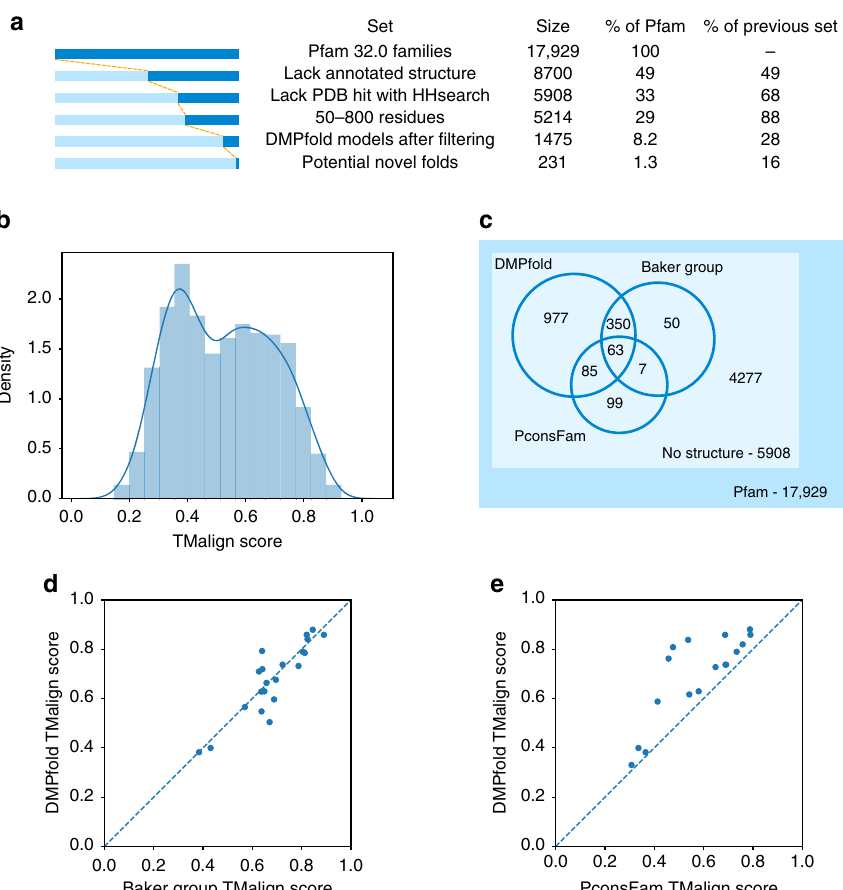
Fig. 4 DMPfold run on Pfam families. a Number of Pfam families at each stage of the analysis. Each set is a subset of the previous set. b The TM-scores using TM-align of generated models to the native structure for the validation set of Pfam families with available structures not used for DMPfold training. c Overlap of high con fi dence models provided by DMPfold with two other studies that generated models for Pfam families. d Comparison of models after re fi nement provided by ref. 19 with our models where a native structure is available. e Comparison of high con fi dence models provided by ref. 13 with our models where a native structure is available. These are not the same families as in